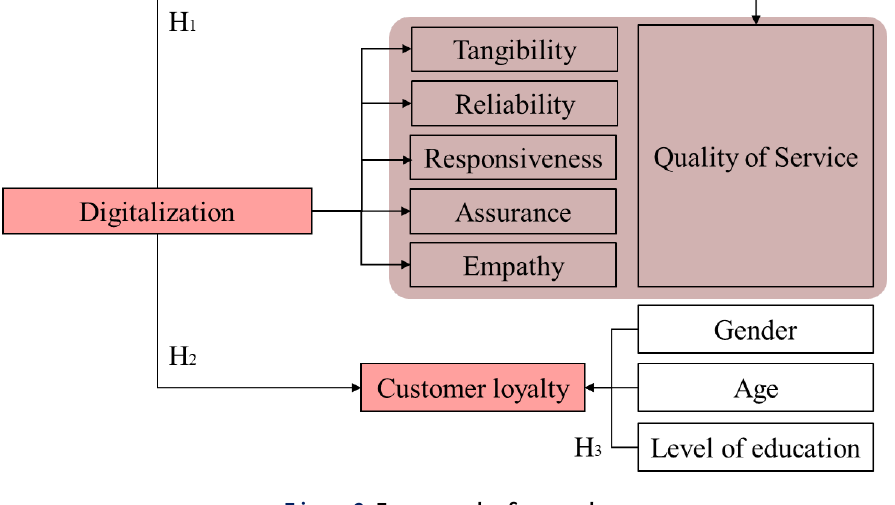
Figure 2. Framework of